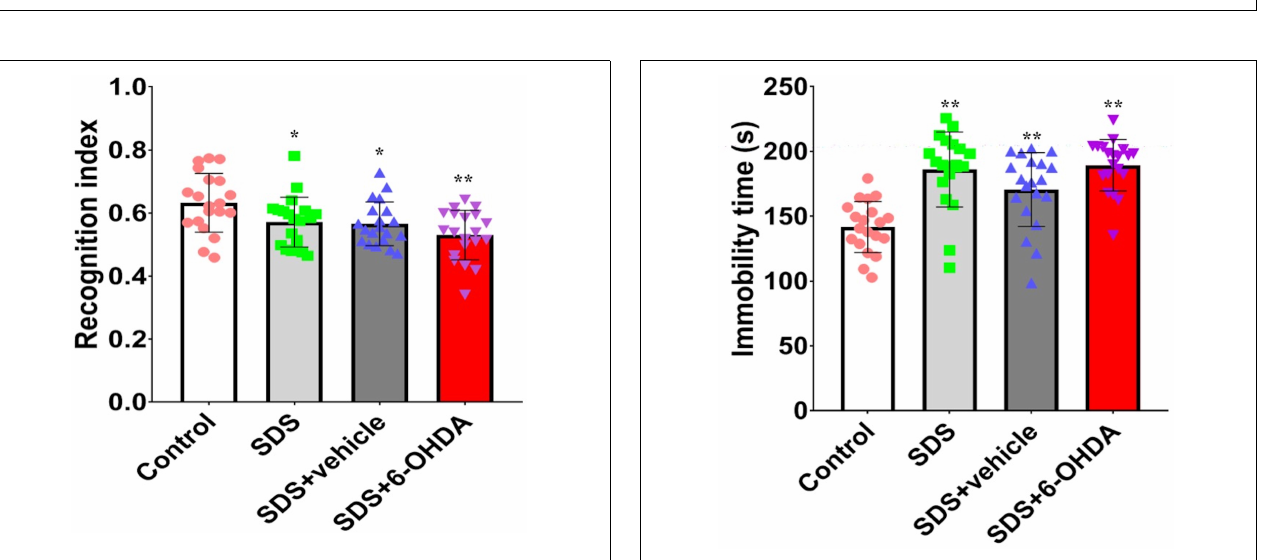
FIGURE 9 | Effects of social defeat stress on forced swimming in the 6-OHDA lesioned mice. ** p < 0.01, compared with the control group ( n = 20 per